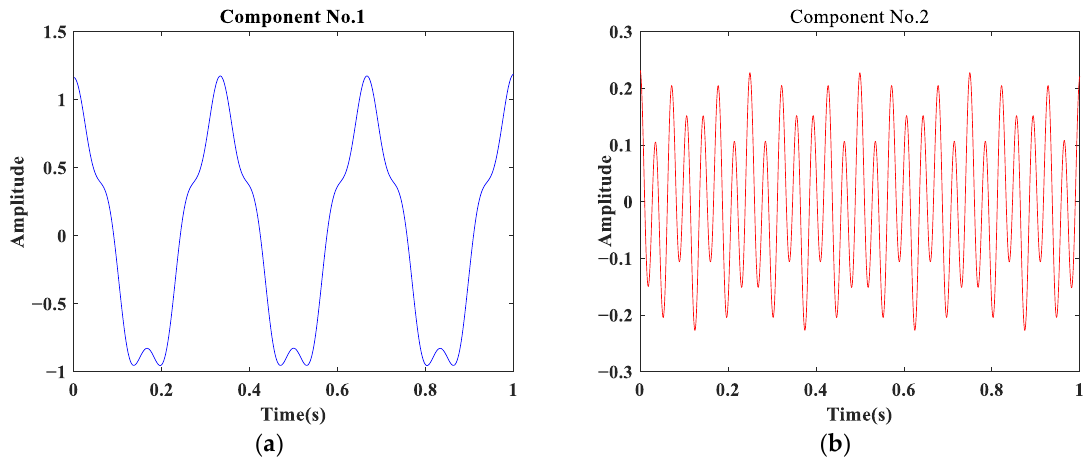
Figure A2. The decomposition result by VMD when K = 3. ( a ) No.1 mode component; ( b ) No.2 mode component.